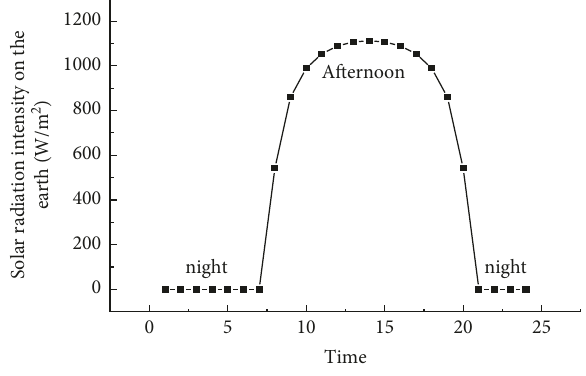
Figure 1: The daily variation of solar